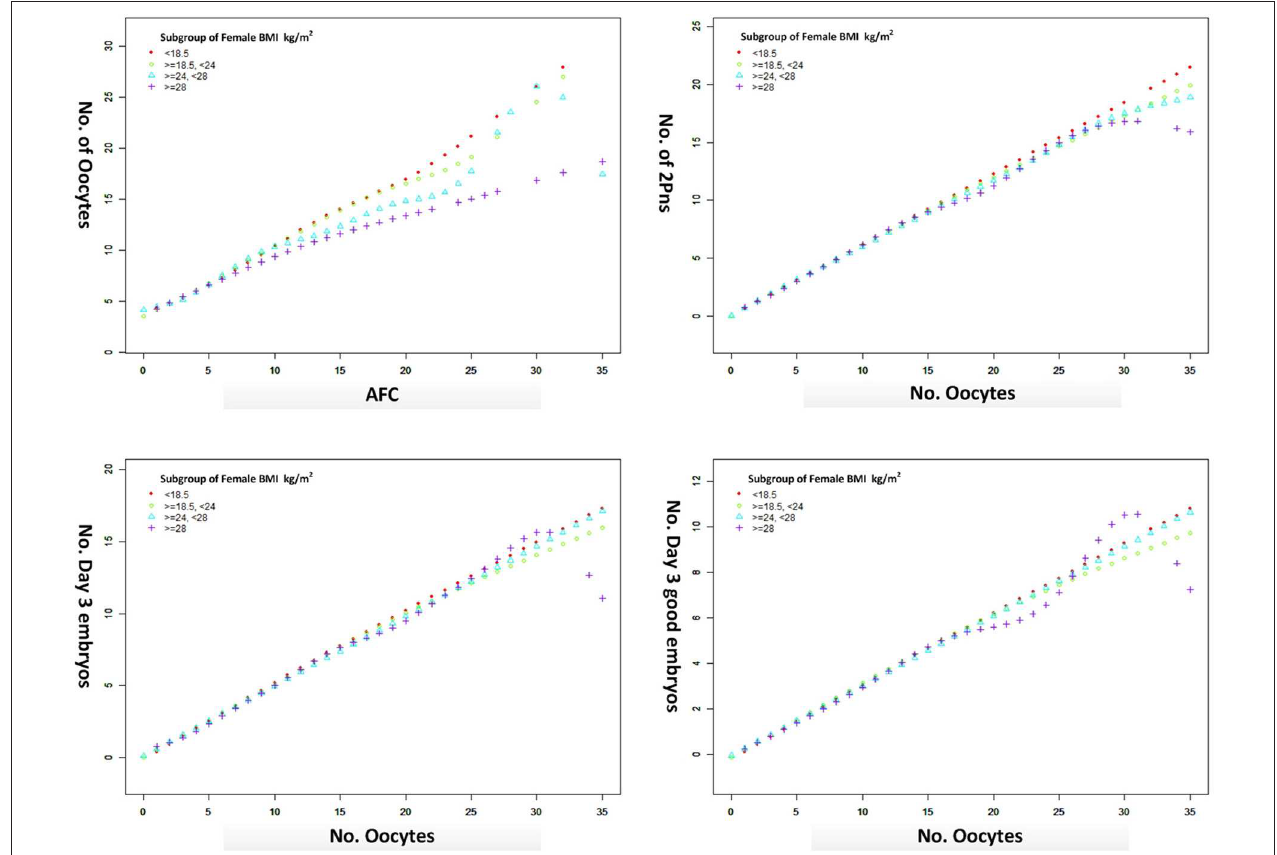
FIGURE 3 | The oocyte retrieval (number of oocytes/AFC) and embryo development (number of 2pn, day 3 embryos and good embryos/no. oocytes) in different subgroups of BMI from a generalized additive model, adjusted for female age, main etiology, and OS protocol.